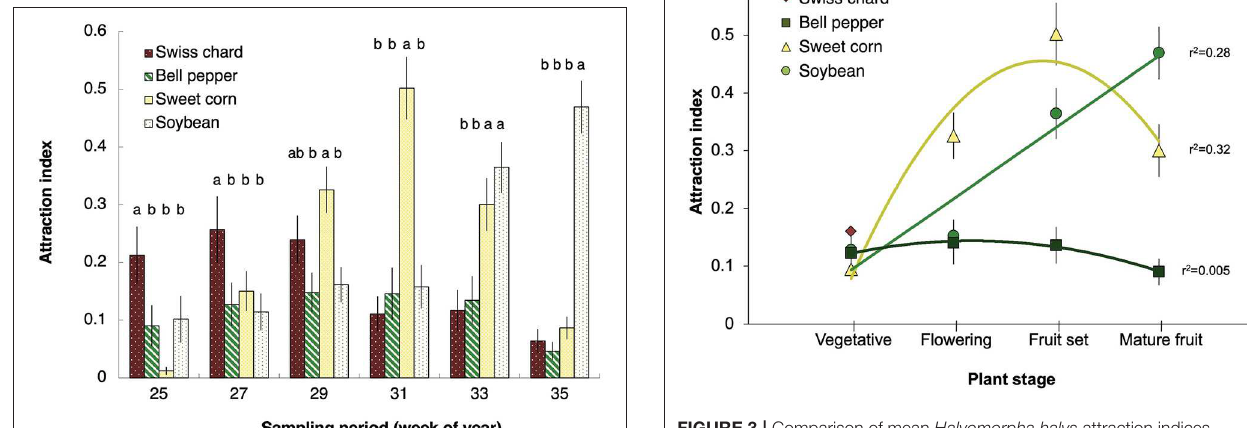
FIGURE 3 | Comparison of mean Halyomorpha halys attraction indices ( ± standard error) with plant phenological growth stage for host plants. Bell pepper and sweet corn were analyzed with a quadratic regression, soybean with a linear regression, and Swiss chard did not have growth stages beyond “vegetative” so no regression analyses were